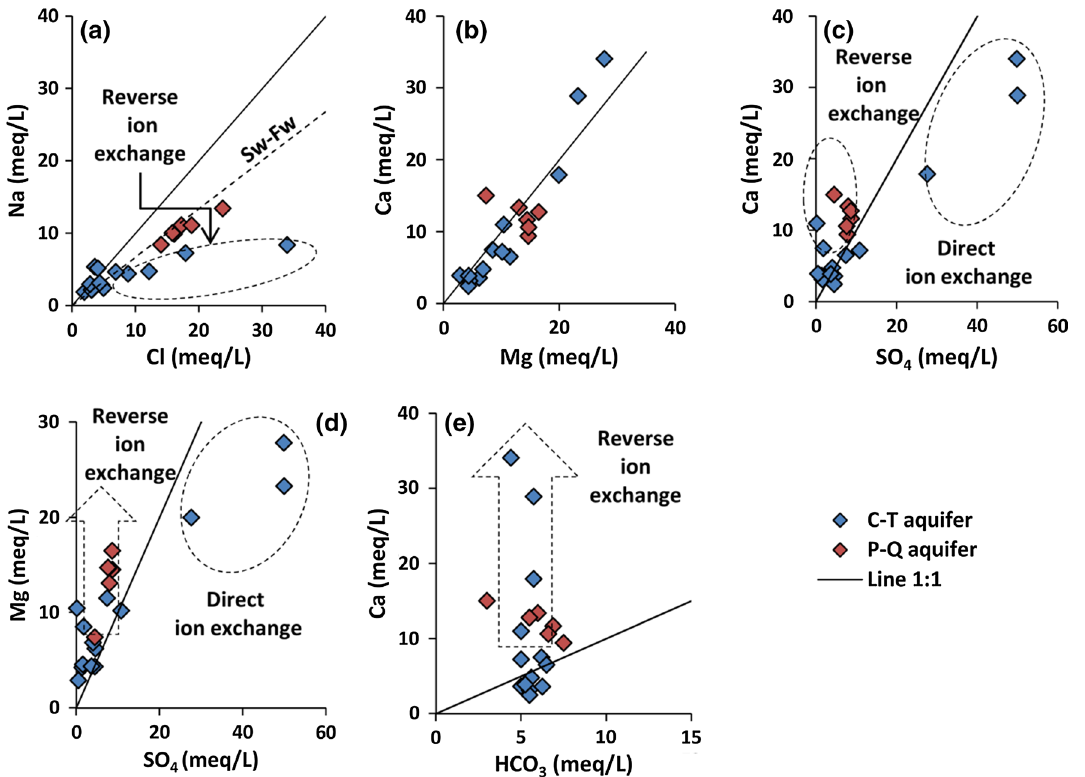
Fig. 6 Correlation diagram a Na versus Cl b Ca versus Mg c Ca versus SO nian, P-Q =